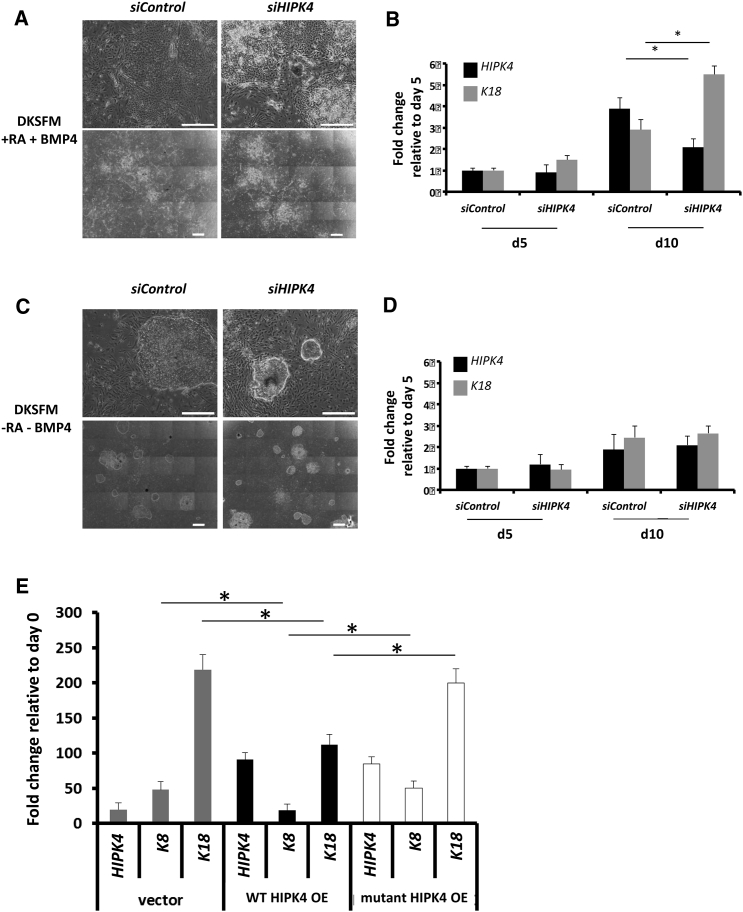
Loss of HIPK4 Alone Is Not Sufficient to Induce Differentiation but Its Kinase Activity Is Necessary to Upregulate K8/K18(A and C) Bright-field images of cells at day 10 of differentiation in DKSFM medium in the presence (A) or absence (C) of retinoic acid (RA) and bone morphogenetic protein 4 (BMP4) in siControl and siHIPK4 conditions at two different magnifications: top pictures at 20× (scale bar, 600 μm); bottom pictures are a combination of 36 images at 4× (scale bar, 1,000 μm).(B and D) qPCR analysis of HIPK4 and K18 in the presence (B) or absence (D) of RA and BMP4 at day 5 and day 10 is presented. Data represent the mean of three independent experiments ± SEM. Statistical analysis was performed using unpaired Student's t test (∗p < 0.05).(E) hiPSCs were transduced with an overexpressing vector for wild-type HIPK4 (WT HIPK4 OE) or kinase dead mutant HIPK4 (mutant HIPK4 OE), or with an empty vector, and differentiated for 10 days. RNA expression of HIPK4, K8, and K18 is shown. Data represent a mean of three independent experiments ± SEM. Statistical analysis was performed using unpaired Student's t test (∗p < 0.05).